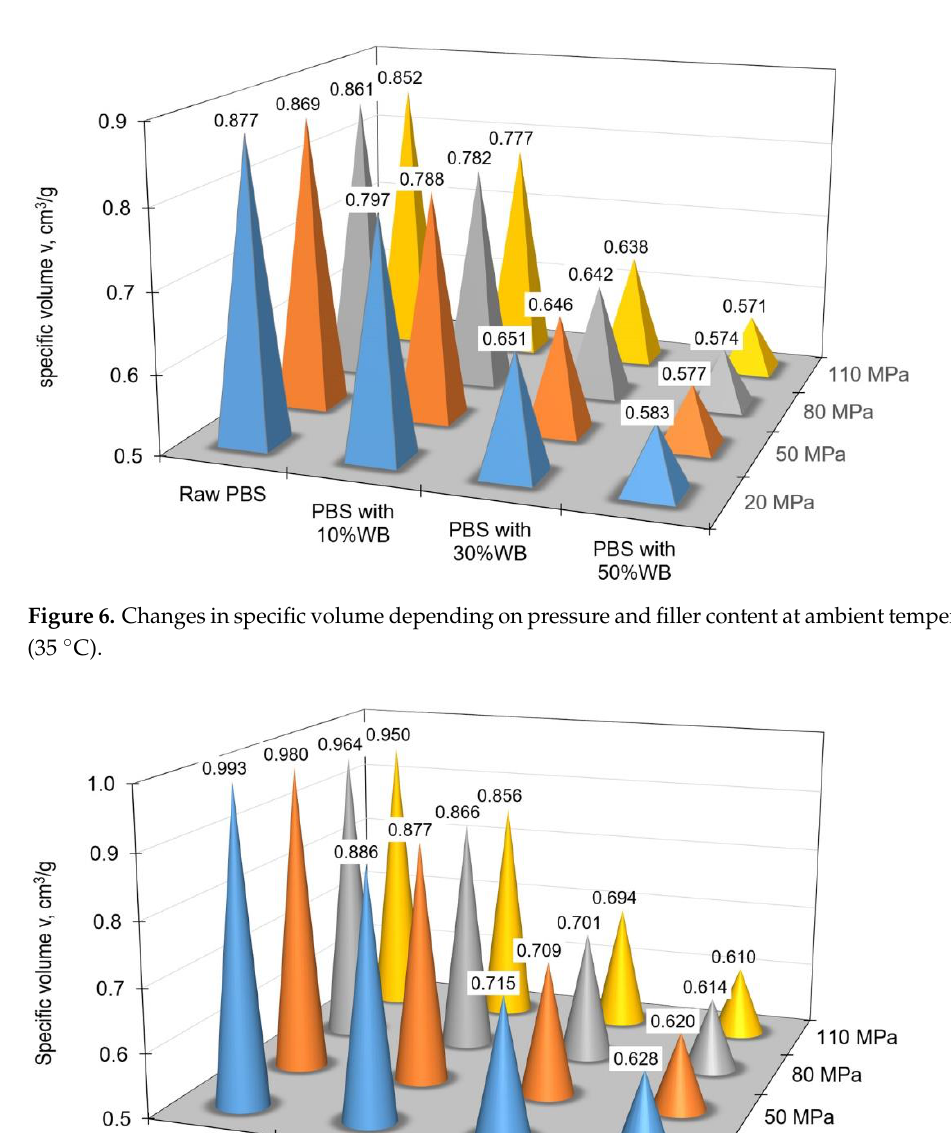
Figure 6. Changes in specific volume depending on pressure and filler content at ambient temperature (35 °C).